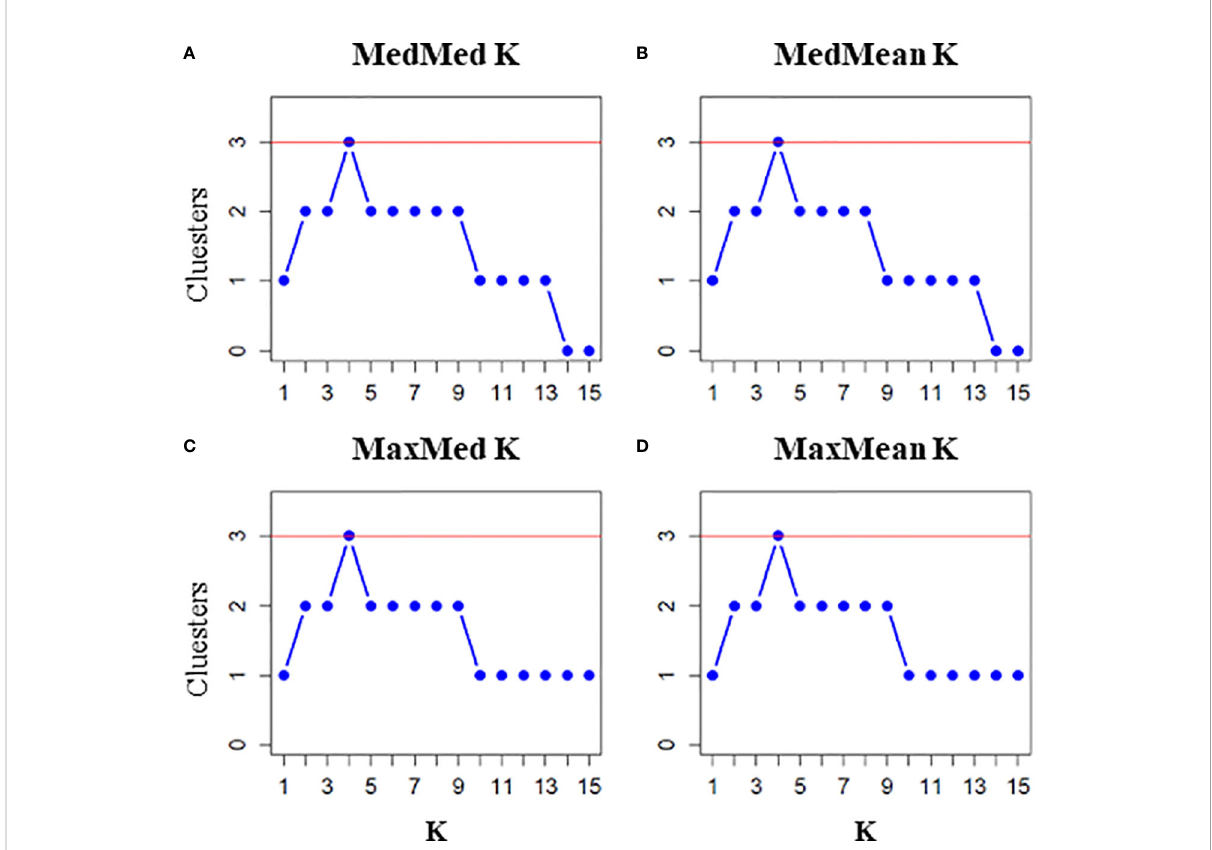
FIGURE 4 Graphical representation of results inferred with STRUCTURESELECTOR for each k and statistics ( A : medmedk; B : medmeak; C : maxmedk; D :